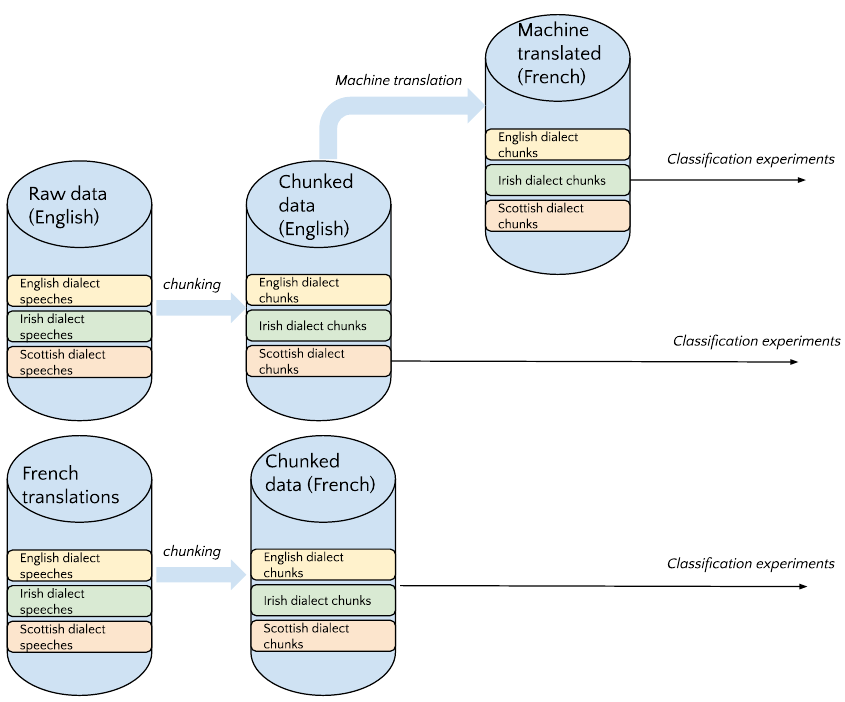
Figure 1. Data collection and